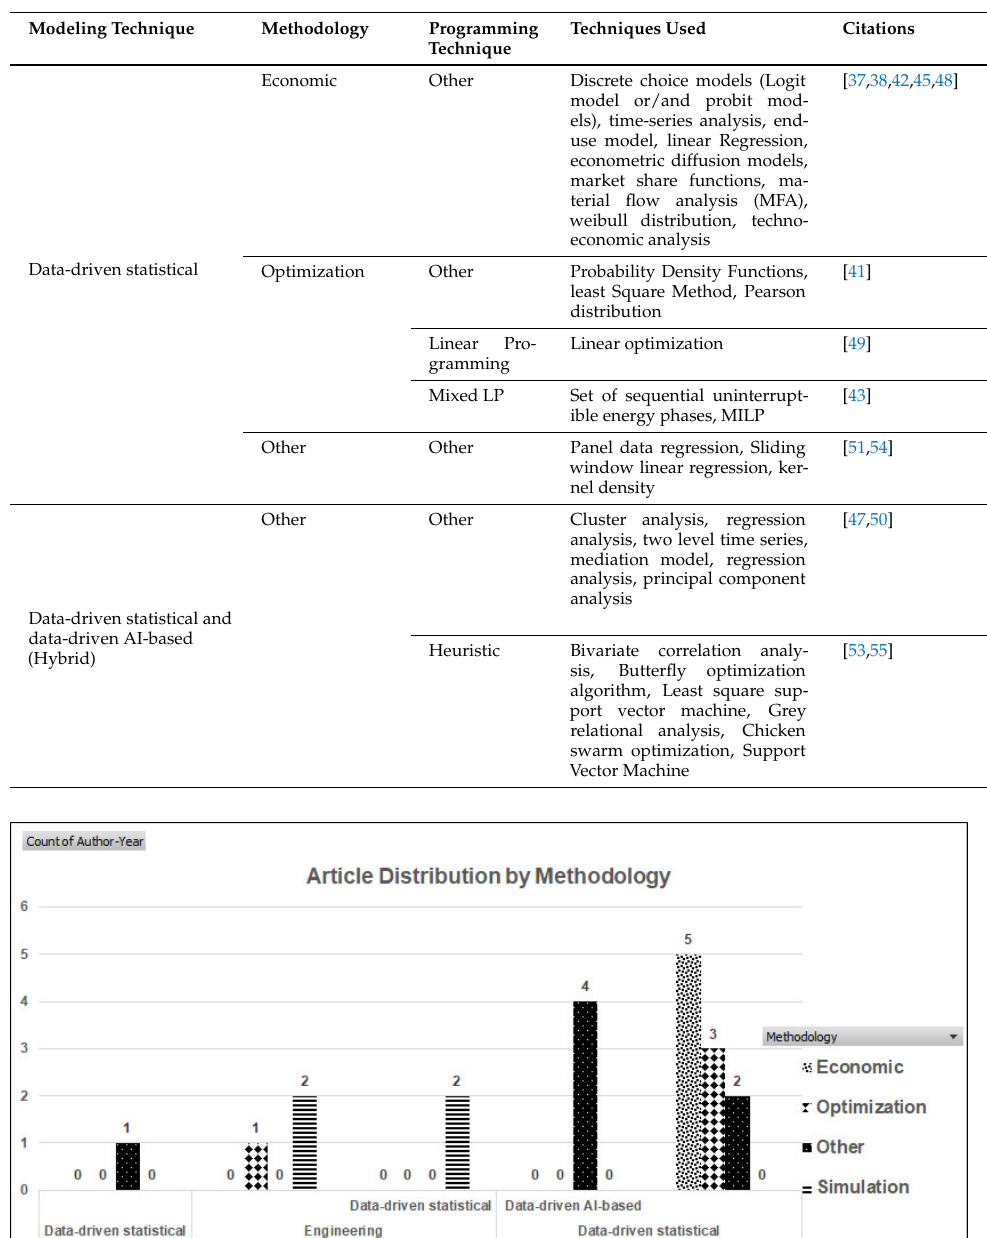
Table 10. Techniques and Methodologies used in bottom-up energy models that support energy efficiency policy design—Residential Sector.